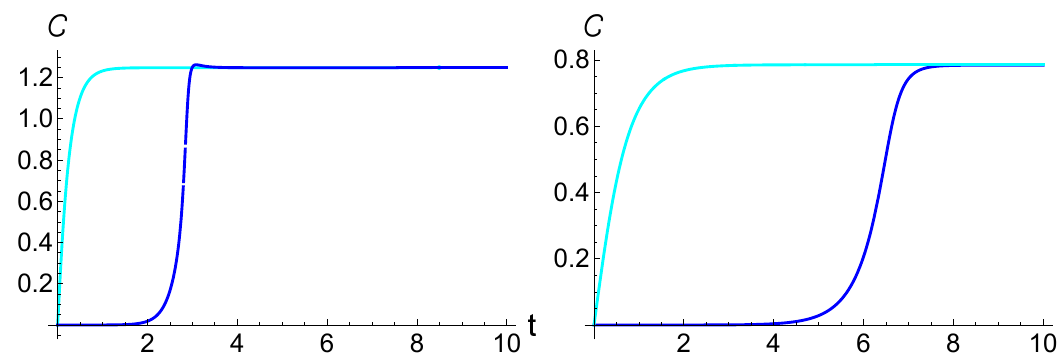
Figure 1 . Left: complexity for single evolved (in cyan) and doubly evolved (in blue) with (cid:15) 1 = − 5 , (cid:15) 2 = − 5 , λ = 0 . 1 , δλ = 0 . 001 and right: complexity for single evolved (in cyan) and doubly evolved (in blue) with (cid:15) = − 1 , (cid:15) = 1 , λ = 0 . 1 , δλ = 0 . 001 1 2